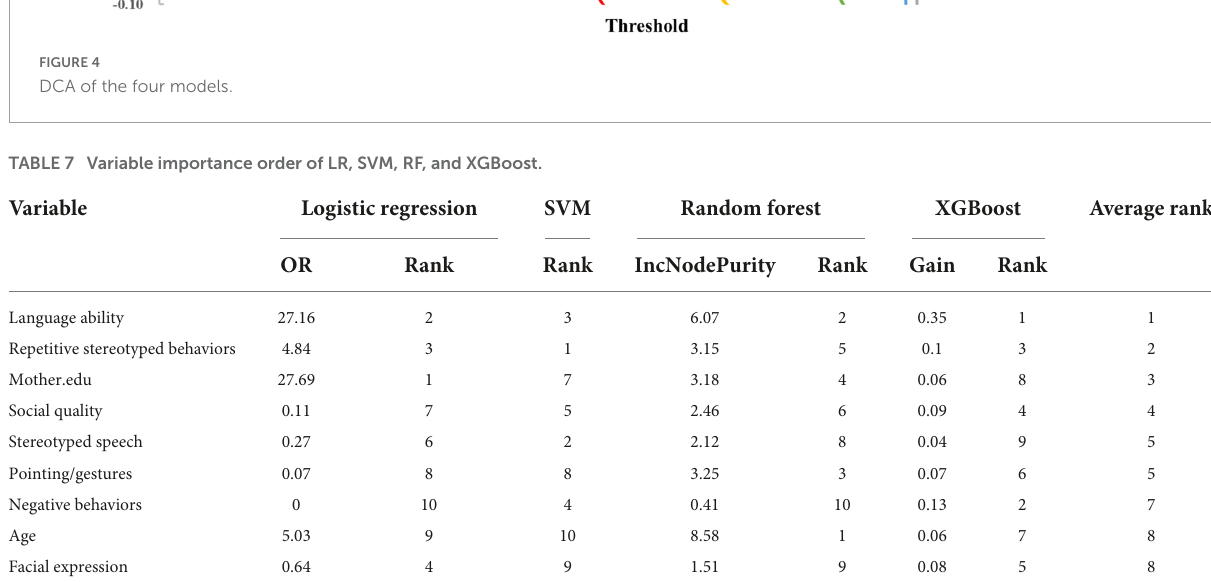
FIGURE4 DCA of the four models.